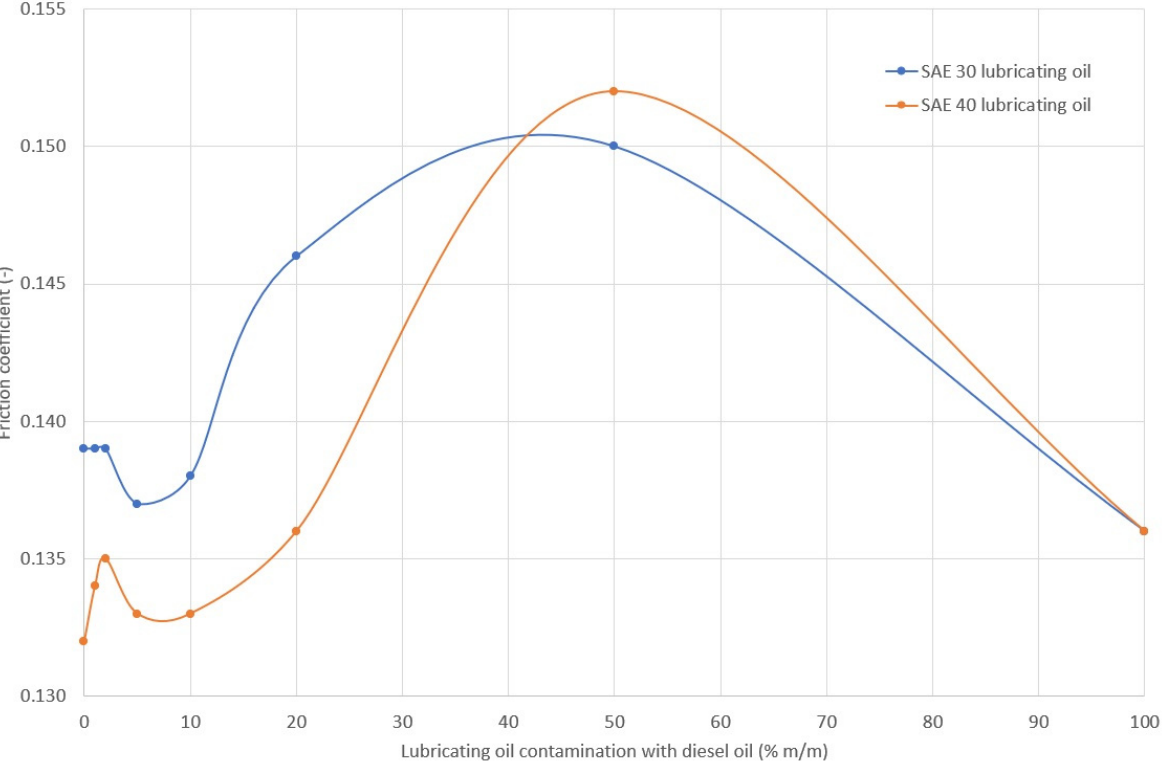
Figure 21. Averaged coefficient of friction of mating elements in the HFFR apparatus separated by a layer from the tested lubricating oils at different levels of lubricating oil dilution with diesel fuel.